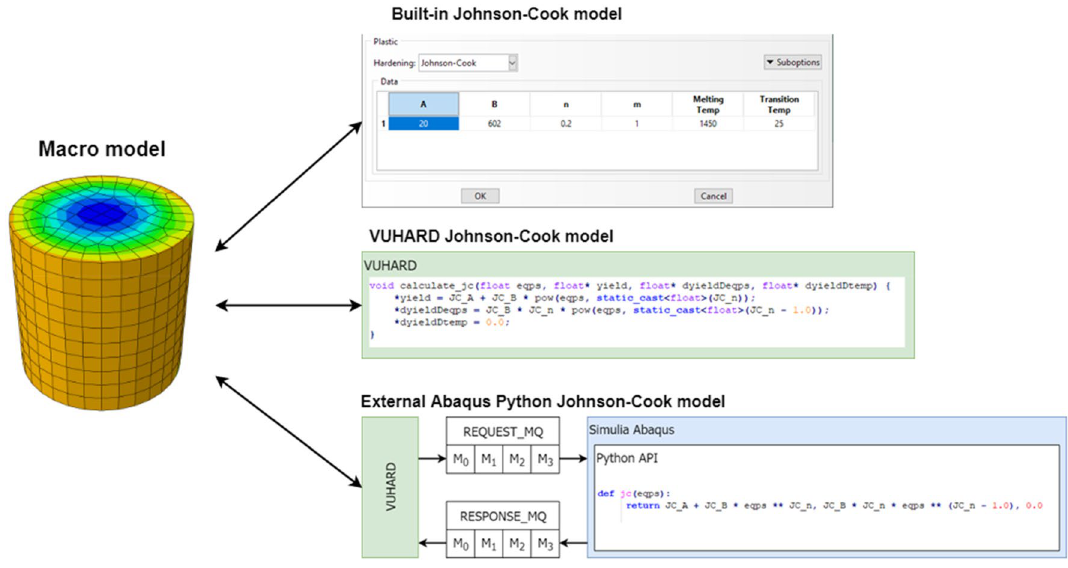
Fig. 6 Diagram showing performed test cases